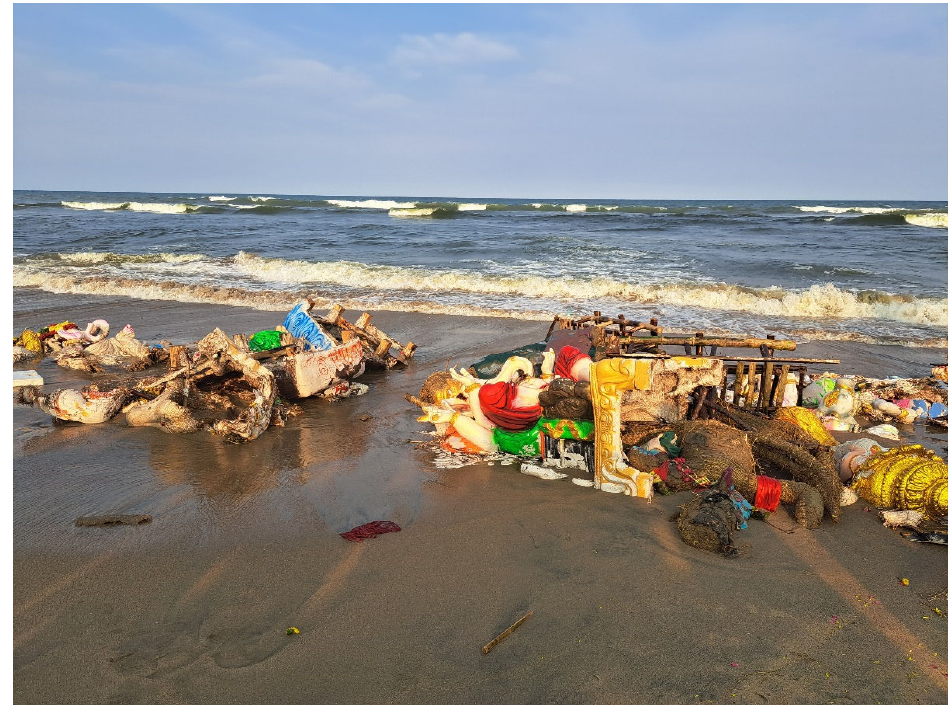
Figure 1. Washed-up Ganeshas at Pattinapakkam beach in Chennai on the day that the visarjan (immersion) of Ganesha took place in 2022. Picture taken by author, 4 September 2022, Chennai.